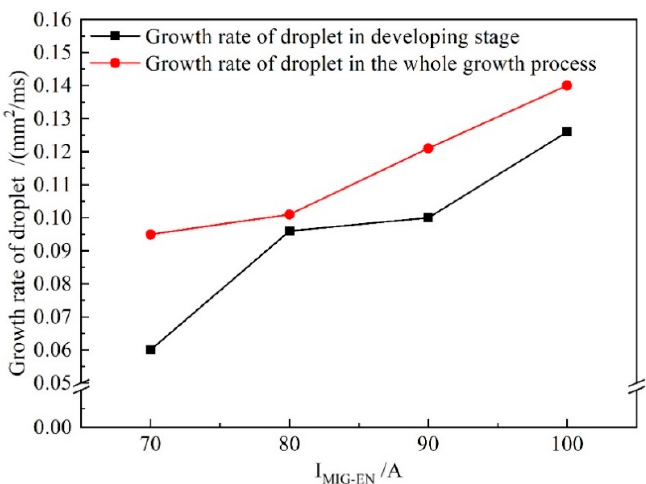
Figure 13. The growth rate of droplet cross-sectional area in the developing stage and the whole growth process when I MIG-EN is increased and I VPPA-EN is maintained at 50 A.